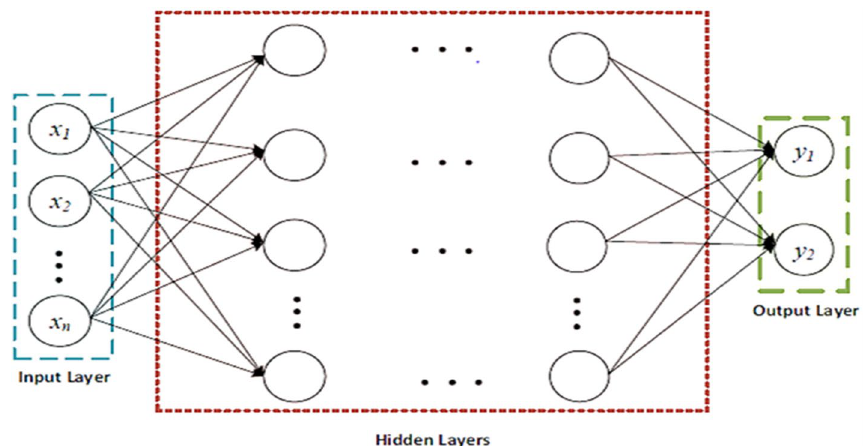
Fig. 1 The Deep Neural Network